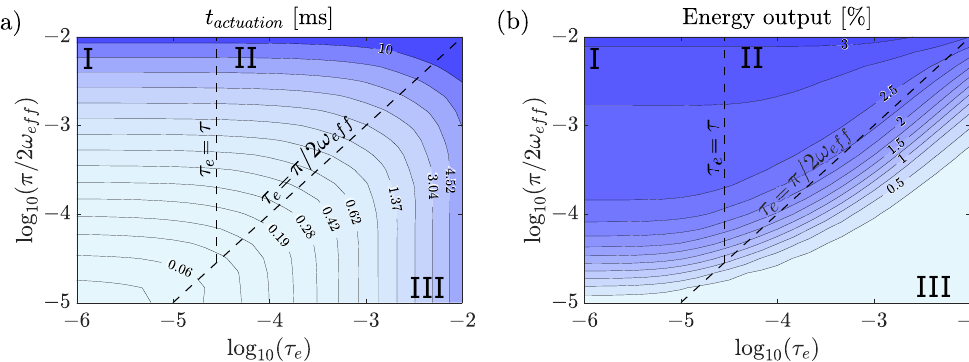
Figure 19. Contour plots of key measures for actuator performance as a function of the heating time, τ e , and the mechanical response time, π /2 ω ef f . ( a ) Total actuation time, t actuation , in ms. ( b ) Energy output (percent), calculated relative to the invested energy for heating up to x = 1. The dashed lines represent boundaries of the different regimes denoted by I, II, and III. In ( a ), lower values (brighter colors) are preferred, while, in ( b ), larger values (darker colors) are